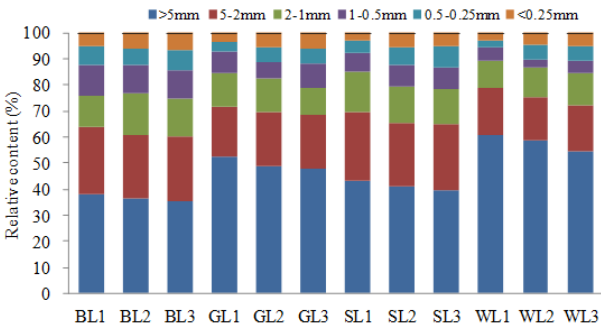
Figure 2. Relative distribution of soil dry aggregates with different sizes under different vegetation types. (BL1, BL2, BL3, GL1, GL2, GL3, SL1, SL2, SL3, WL1, WL2, and WL3 represent 0–20 (1), 20– 40 (2), and 40–60cm (3) soil layers of bare land (BL), grassland (GL), shrubland (SL), and woodland (WL), respectively.)